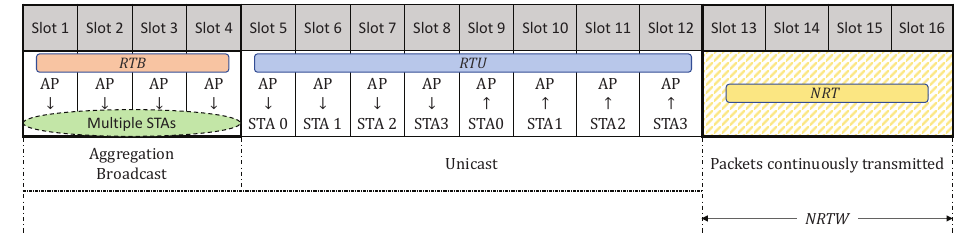
Figure 2. An example of the RT-WiFiQA superframe